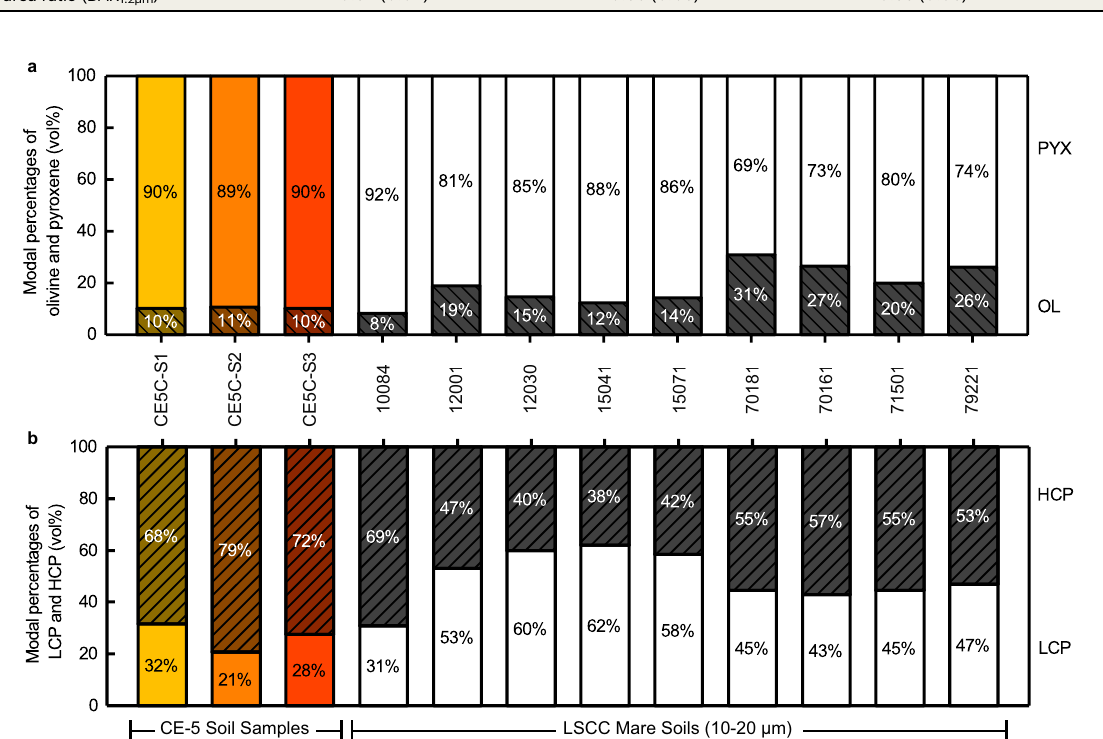
Fig. 4 | Comparison of mineral abundance ratio between CE-5 and Lunar Soil Characterization Consortium (LSCC) mare soil samples. a Modal percentages (vol%)ofolivine(OL)andpyroxene(PYX). b Modalpercentages(vol%)oflow-Ca clinopyroxene (LCP) and high-Ca clinopyroxene (HCP). LSCC data are from ref. 44.For comparison,thesumof OL and PYX, and LCP and HCParenormalized to